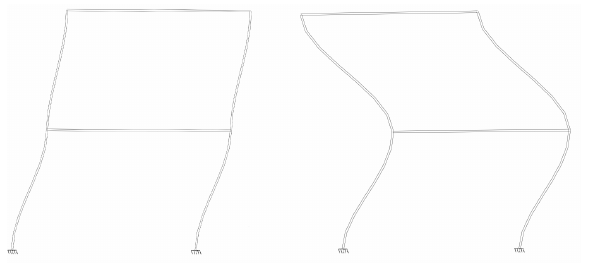
Figure 5. The first and the second